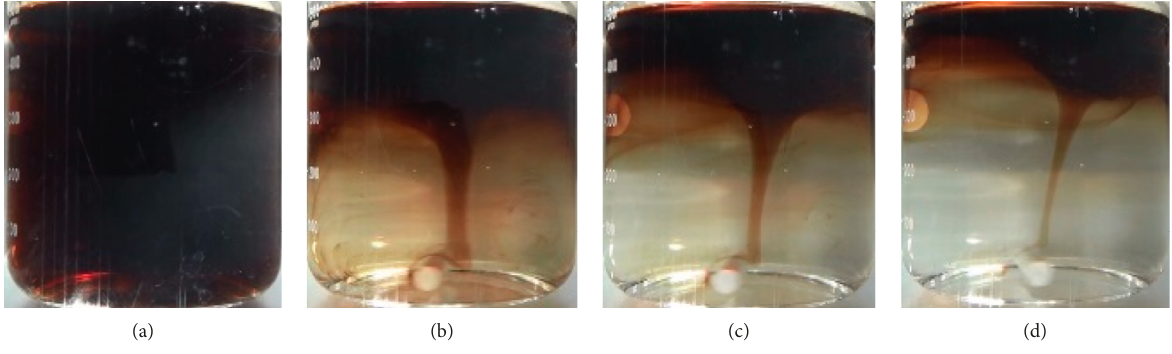
Figure 8: Mixing using a normal bar at n � 100rpm. (a) 0s, (b) 60s, (c) 120s, and (d) 300s.